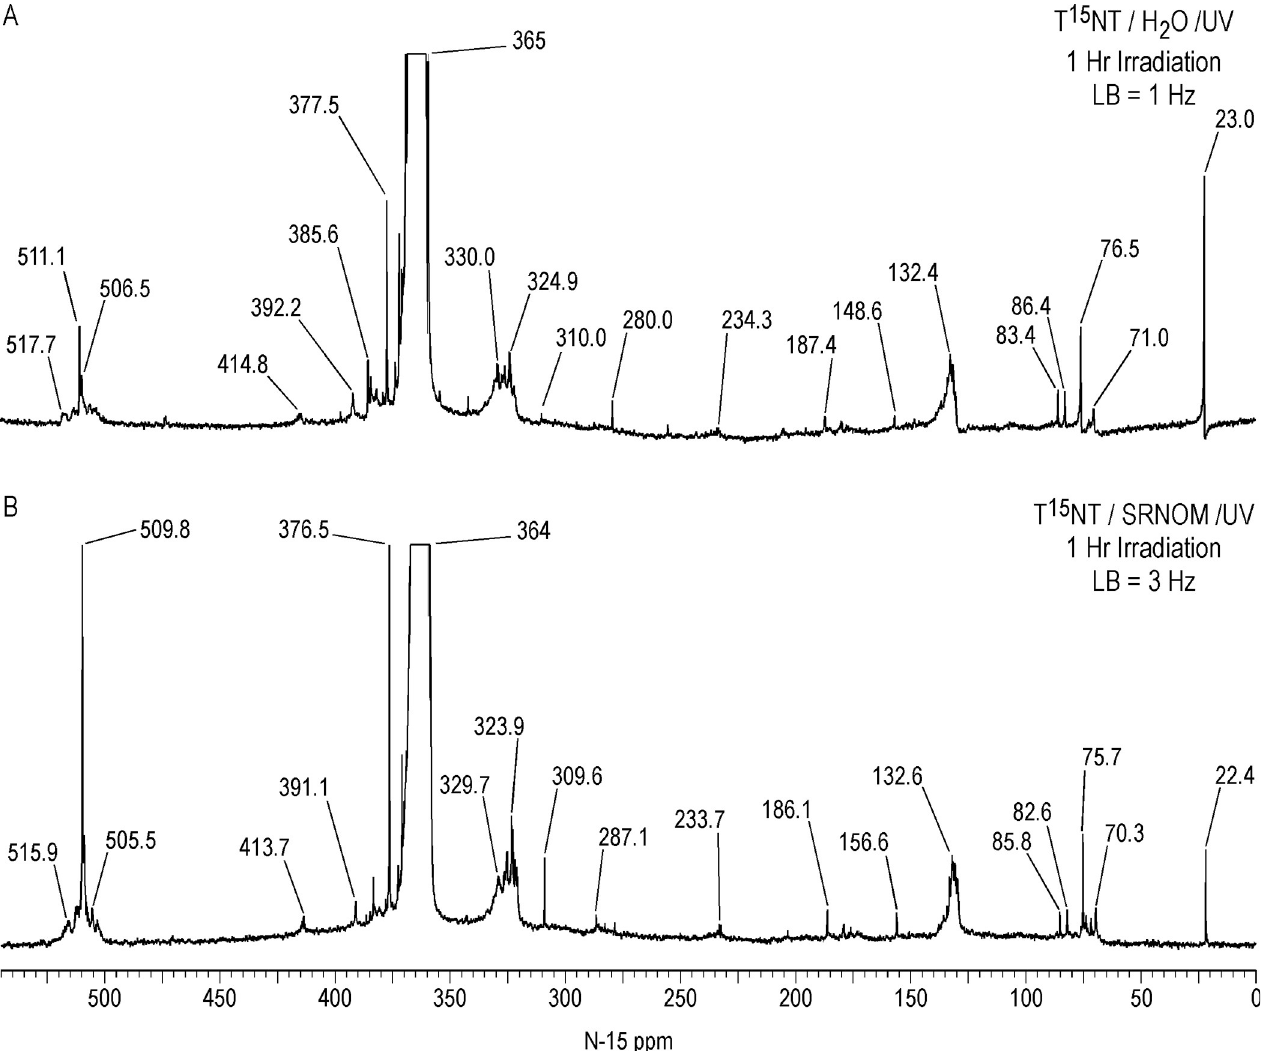
Fig 26. Liquid state IGD N-15 NMR spectra of T 15 NT. A. Lamp irradiation in deionized water. Lamp irradiation in deionized water with Suwannee River NOM added. LB = line broadening. https://doi.org/10.1371/journal.pone.0224112.g026 4 times that of the sunlight irradiation in pond water, 192 times the lamp irradiation in pond water, 192 times the 1 hour lamp irradiation in pH 8 buffer, and 48 times the 4 hour lamp irra- diation in pH 8 buffer. The solid state CP/MAS 13 C NMR spectrum shows methylene carbons at 31 ppm, O-alkyl carbons at 73 ppm, and a bicarbonate and/or carboxyl peak at 165 ppm (Fig 28A). The methylene carbons again may be attributable to structures arising from nucleo- philic addition of the 2,4,6-trinitrobenzyl anion to the C carbon of a second TNT molecule. 3 The CP/MAS 15 N NMR spectrum (Fig 28B) shows low intensity peaks at 74 ppm (1˚ aromatic amine or 2˚ anilinohydroquinone) and 116 ppm (1˚ amide or 2˚ anilinoquinone)[87]. Consid- ering the excess length of exposure to alkaline conditions of the dark control over the irradia- tion experiments, and the relatively minor degree of transformation in the dark, especially with respect to nitrogen, it is unlikely that the transformation of TNT during irradiation in the pond water and in the pH 8 buffer that can be attributed to hydrolysis alone is significant. The